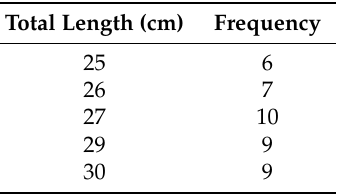
Table 4. Length frequency key of sampled fish from Cage2.